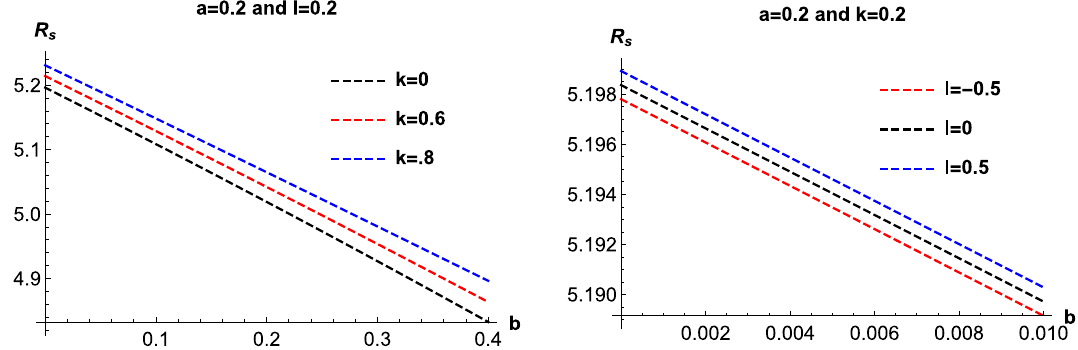
Fig. 10 The figure at the left side represents the variation of shadow radius R s with b for different values of k with a = 0 . 2 and l = 0 . 2. The figure at the right side represents the variation of R s with b for different values of l with a = 0 . 2 and k = 0 . 2